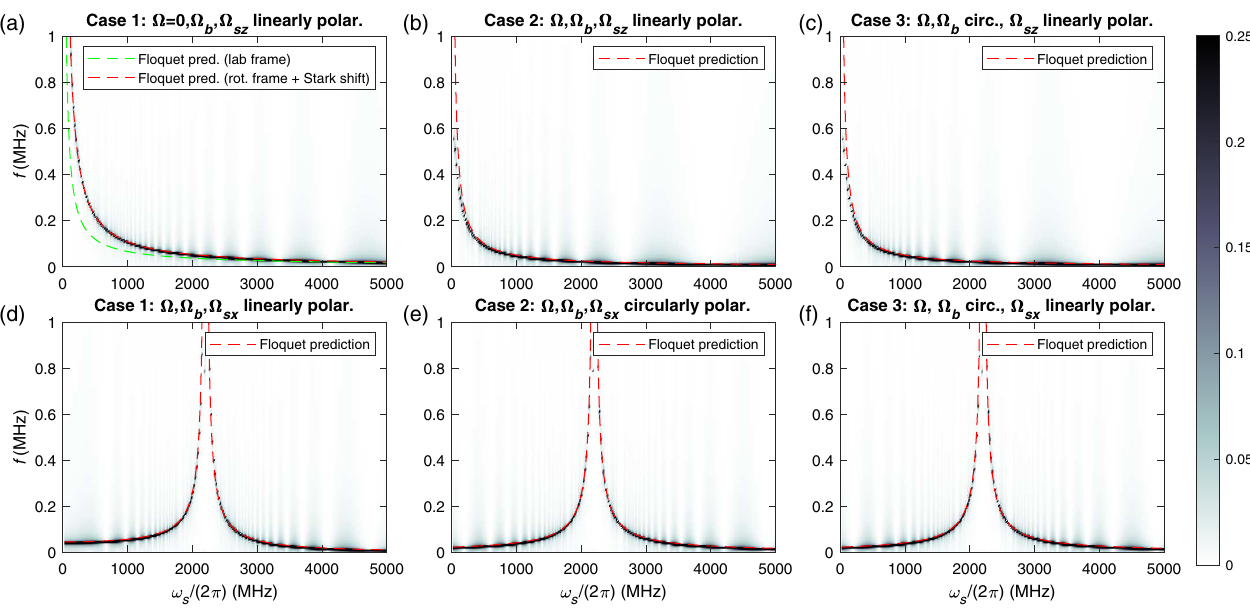
FIG. 8. Signal frequency ω s sweep (intermediate frequency). The parameters are the same as in Fig. 7 except for the qubit energy ω 2 π Þ 2200 MHz. Resonance conditions ω 0 ¼ ð sweeping ω s